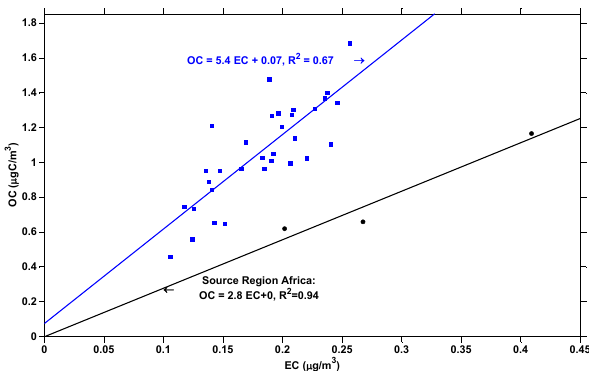
Fig. 10. OC versus EC as determined by PM 1 filters. The slope of the OC versus EC line was 5.4 (blue points) for the study period with the exception of 19–21 May (source region Africa), when it was equal to 2.8 (black